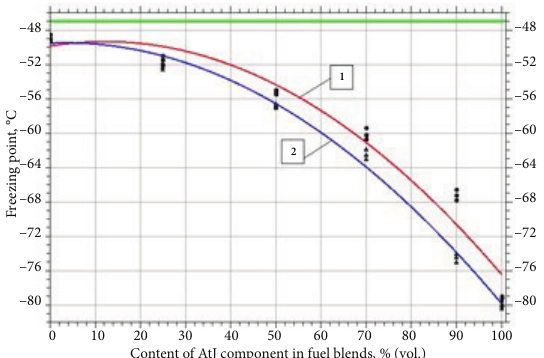
Figure 5. Dependence of the freezing point of JF blends on the content of AtJ components produced from alcohols: